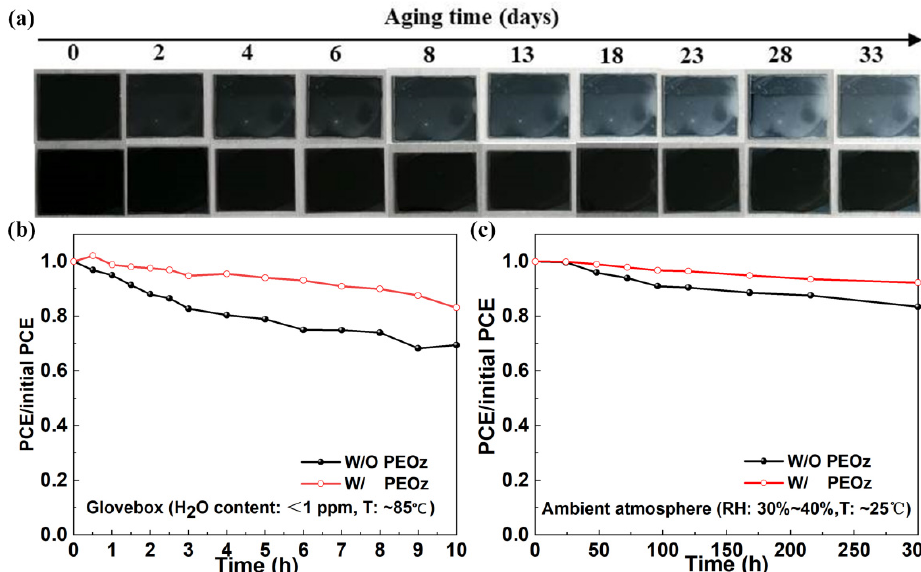
Figure 7. ( a ) Photographs of the MA 0.7 FA 0.3 PbI 3 − x Cl x films with and without PEOz passivation layer during exposure to a relative humidity of 30~40% over 29 days. ( b ) Thermal stability and ( c ) Wet stability results of the device with and without PEOz, respectively.